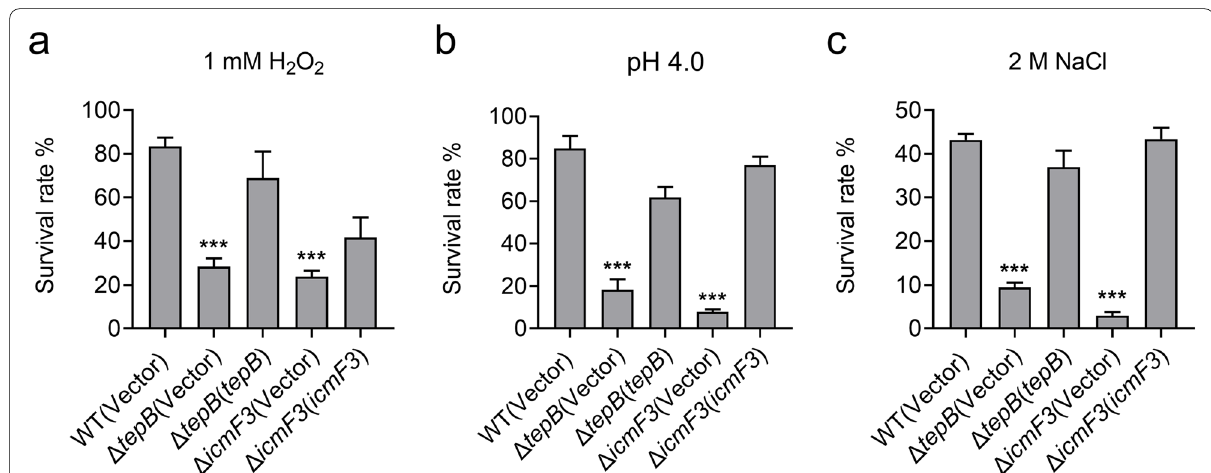
Fig. 3 H3-T6SS and TepB are involved in oxidative, acid and osmotic stress resistance. a , b and c The viability of mid-exponential phase P. aeruginosa PA14 strains was determined after challenge with 1 mM H 2 O 2 ( a ), pH 4.0 ( b ) or 2 M NaCl ( c ) for 30 min. Statistical analyses for the rest of the assays were performed using unpaired two-tailed Student’s t -test. Data represent the mean performed with three technical replicates. *** P <